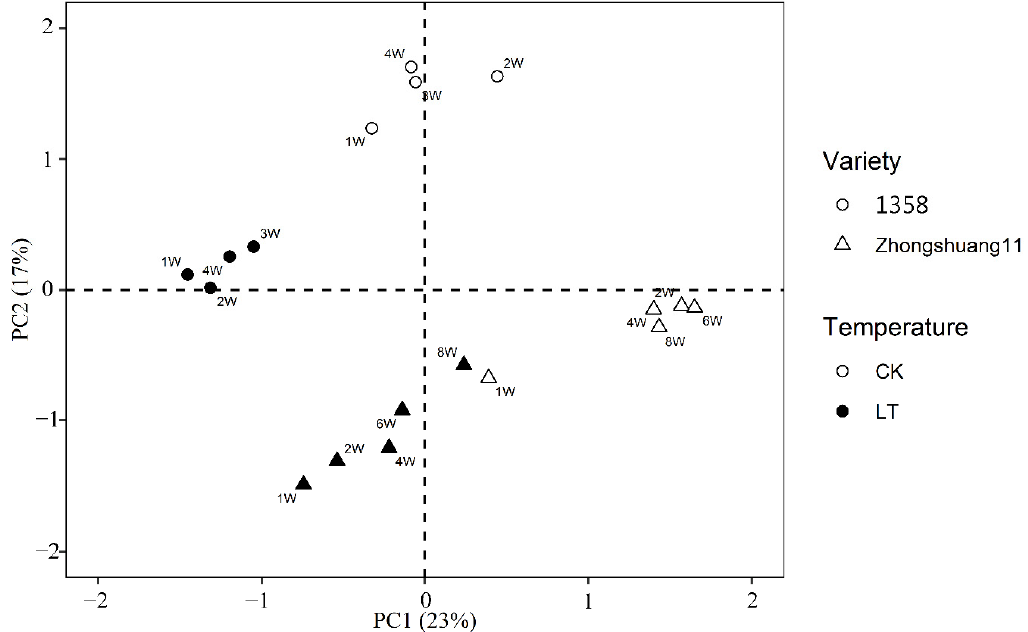
Figure 5. Principal component analysis (PCA) of transcript profiles for the samples. PC1 and PC2 represent principal component 1 and principal component 2, respectively.